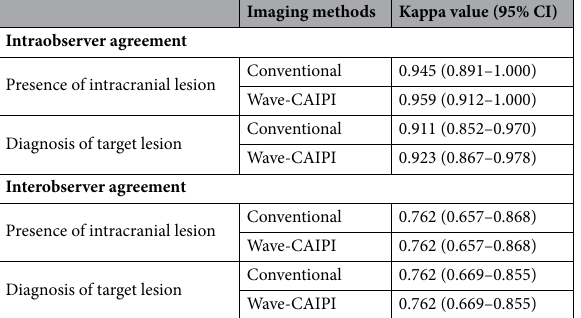
Table 3. Intraobserver and interobserver agreement between conventional and wave-CAIPI MPRAGE. CI confidence interval, MPRAGE magnetization-prepared rapid gradient echo, wave-CAIPI wave-controlled aliasing in parallel imaging.